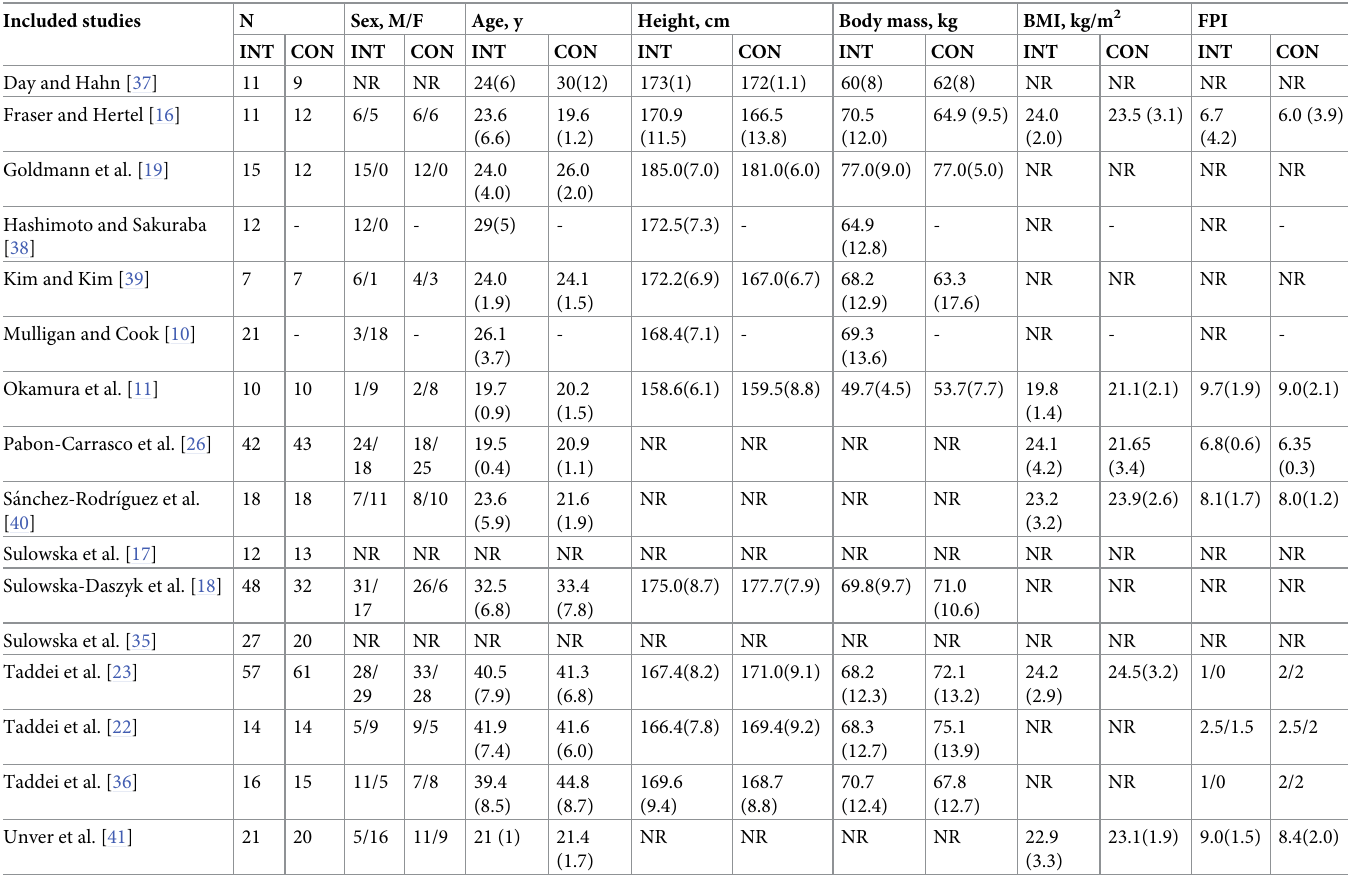
Table 3. Sample sizes and participant characteristics for each included